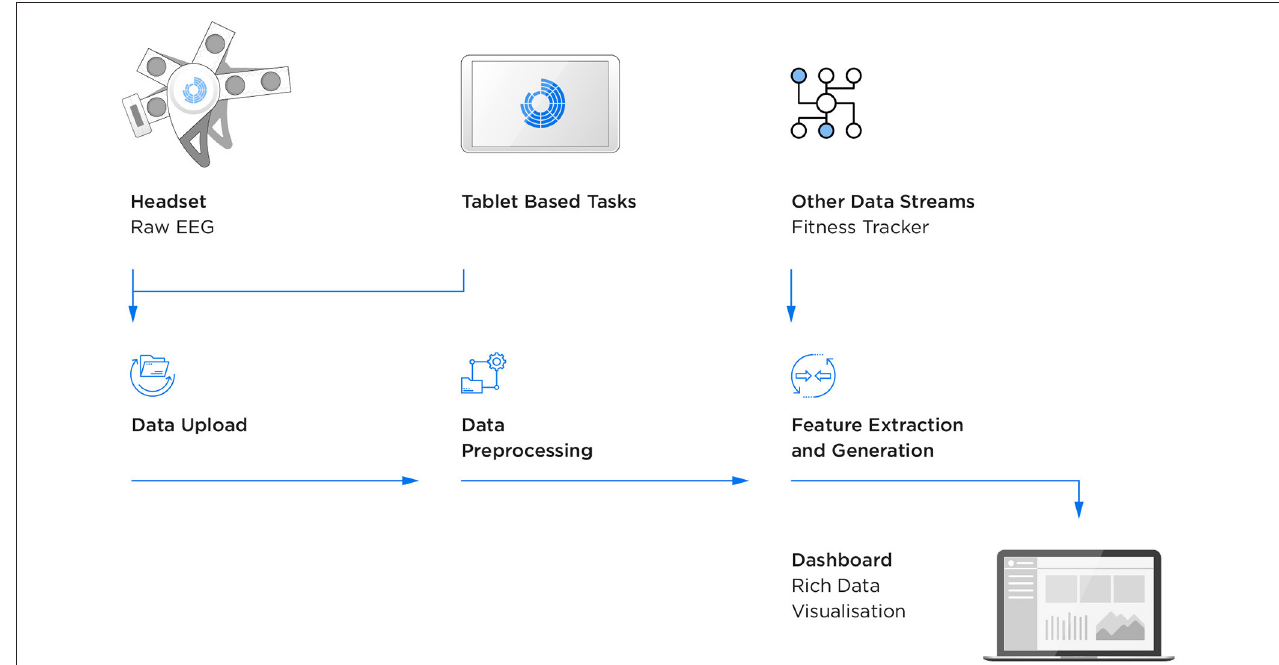
FIGURE 1 | Flow of EEG and behavioural